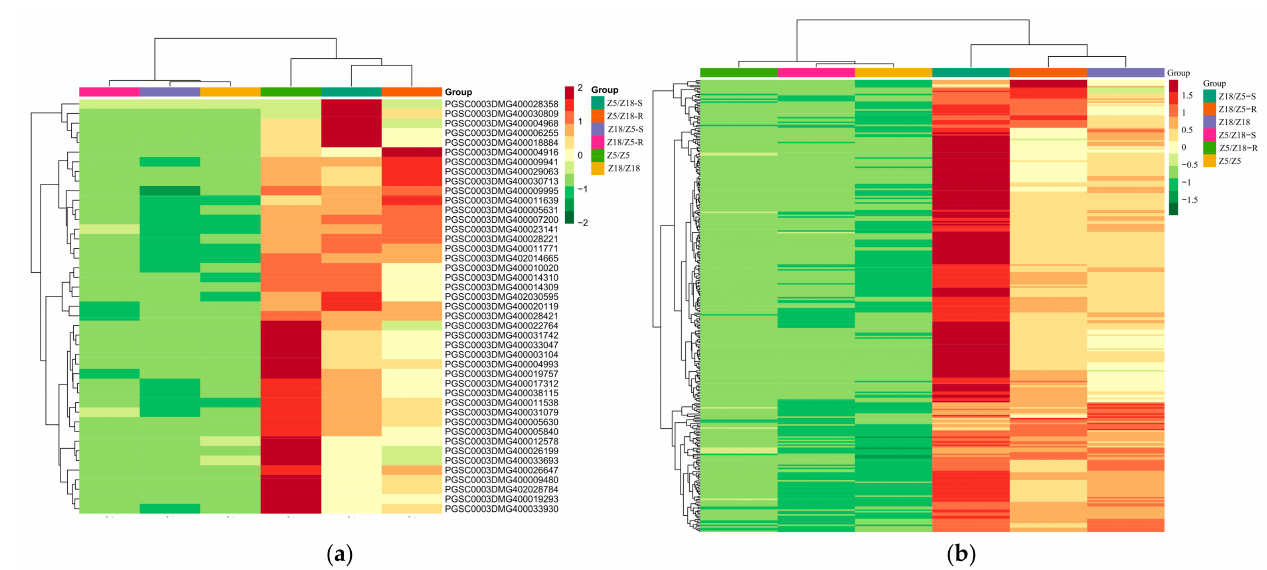
Figure 3. Clustering heat map of long-distance transport mRNAs related to early-maturity ( a ) and late-maturity ( b ) Z5/Z18-S: Z5 stems of Z5/Z18 grafts. Z5/Z18-R, Z18 stems of Z5/Z18 grafts. Z18/Z5-S: Z18 stems of Z18/Z5 grafts. Z18/Z5-R: Z5 stems of Z18/Z5 grafts. Z5/Z5: stems of Z5/Z5 grafts. 18/Z18: stems of Z18/Z18 grafts. Gene expression level by color: red indicates upregulated, green represents